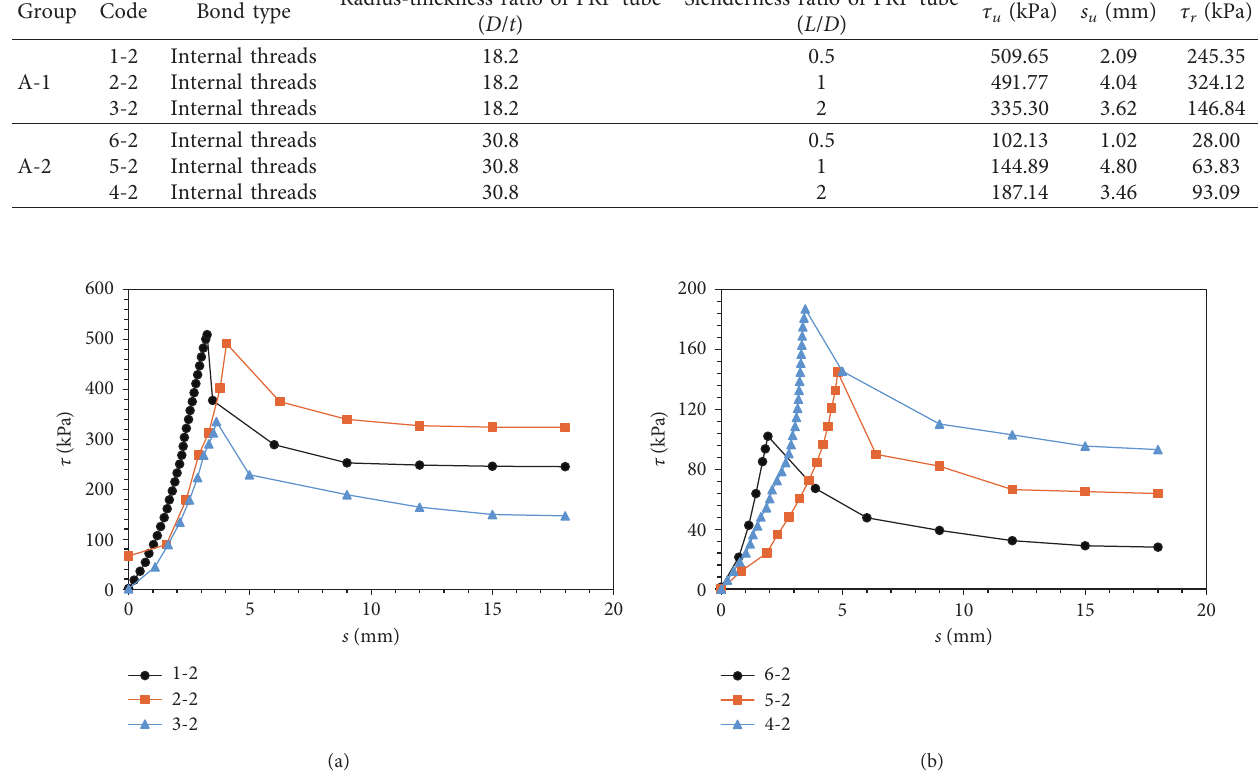
Figure 7: τ − s curves of Group A-1 and A-2. (a) τ − s curves of Group A-1. (b) τ − s curves of Group